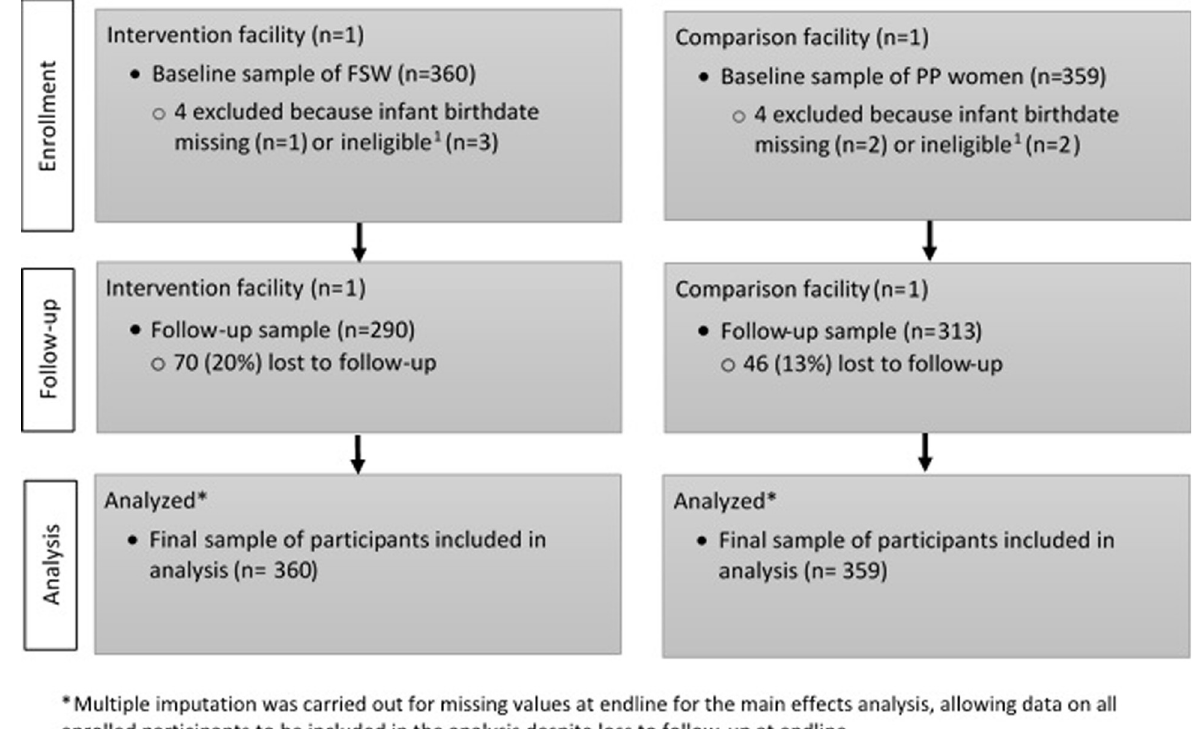
Fig 1. Consort flow